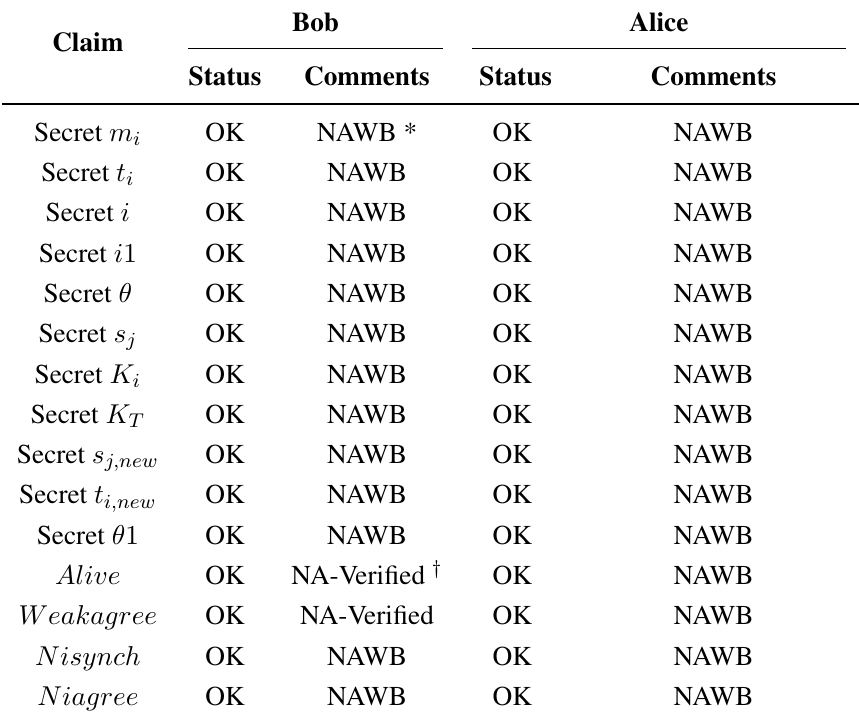
Table 5. Results: Evaluation of the Protocol Using Scyther